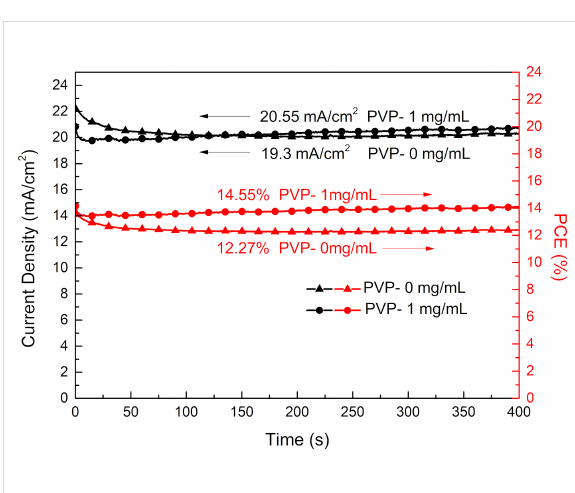
Figure 9: The stable output current density and PCE at the max power point of PSCs.